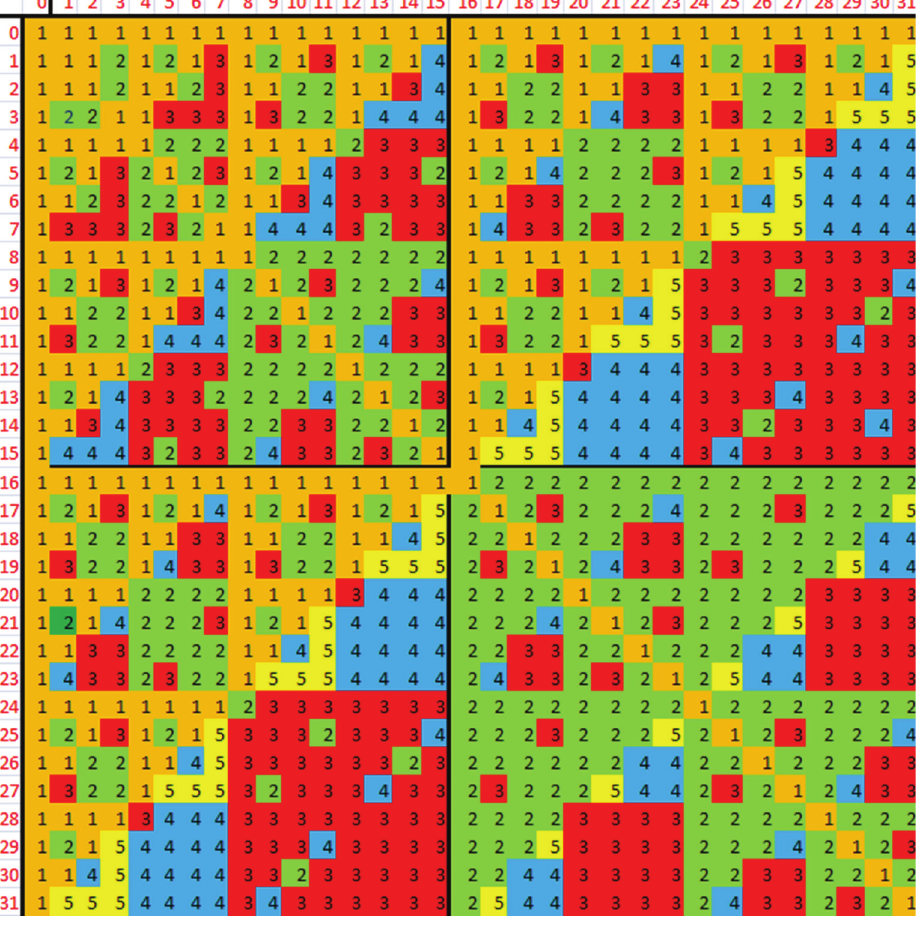
Figure 4: Showing the number of iterations required for either CVT (cid:4) 0 or XOR (cid:4)